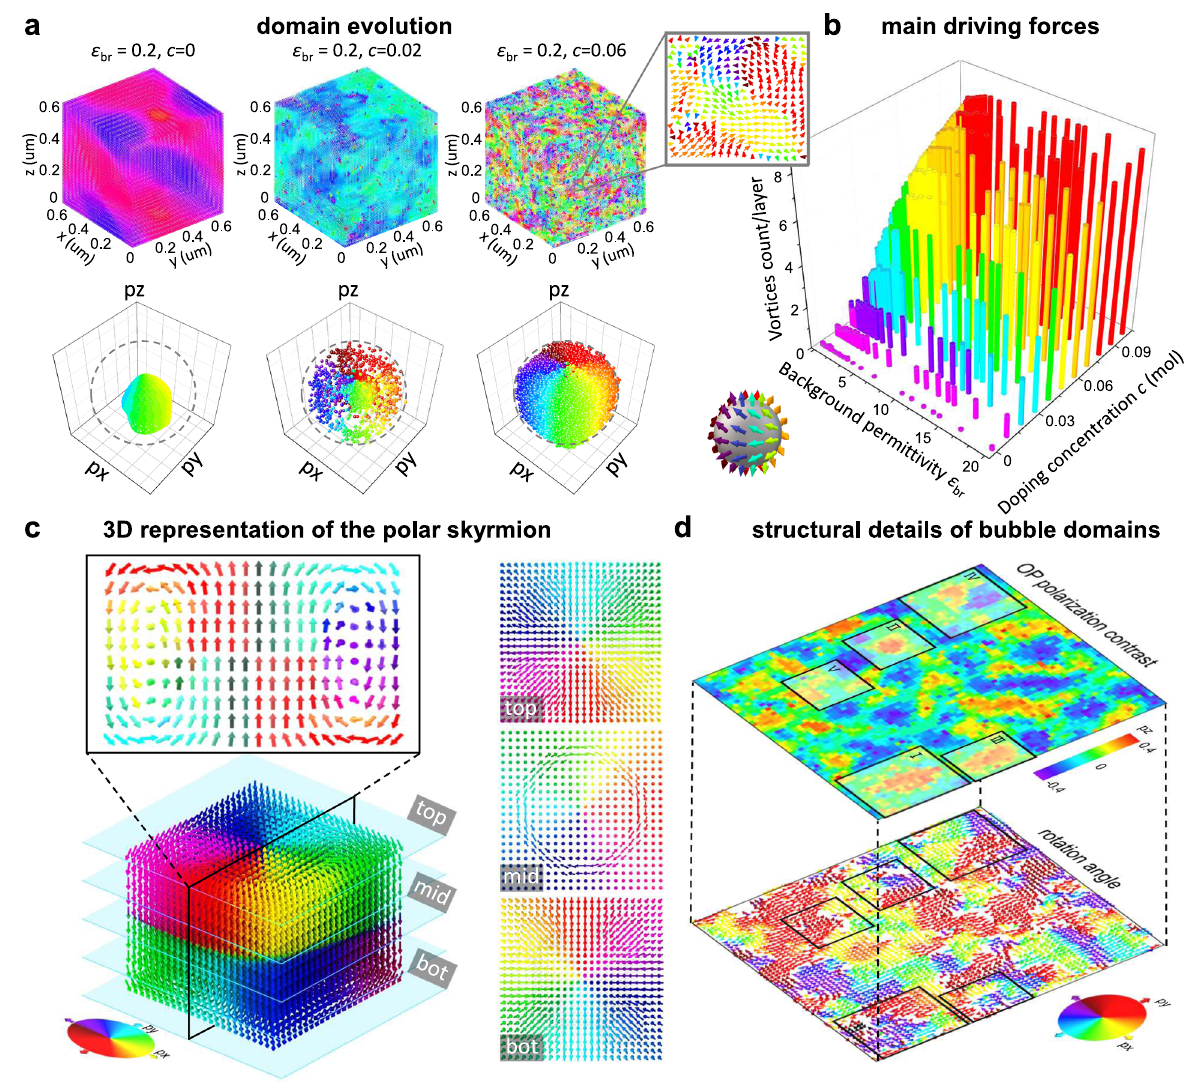
Fig. 4 Origin and structural details of bubble domains. a The upper part shows the domain evolution with increasing doping concentration, and the lower part shows the corresponding polarization distribution. The expanded region (upper-right corner) shows the local polarization distribution derived from the bubble-like domain structure. b Main driving forces to form the bubble-like domain structure. c 3D representation of a polar skyrmion selected from the bubble domains. d Theoretical reconstruction of the bubble domains. Regions I − V are selected regions, which re fl ect the multiple topological con fi gurations in the bubble domains. More domain evolution and driving forces and structural details can be seen in Supplementary Figs. 11 −